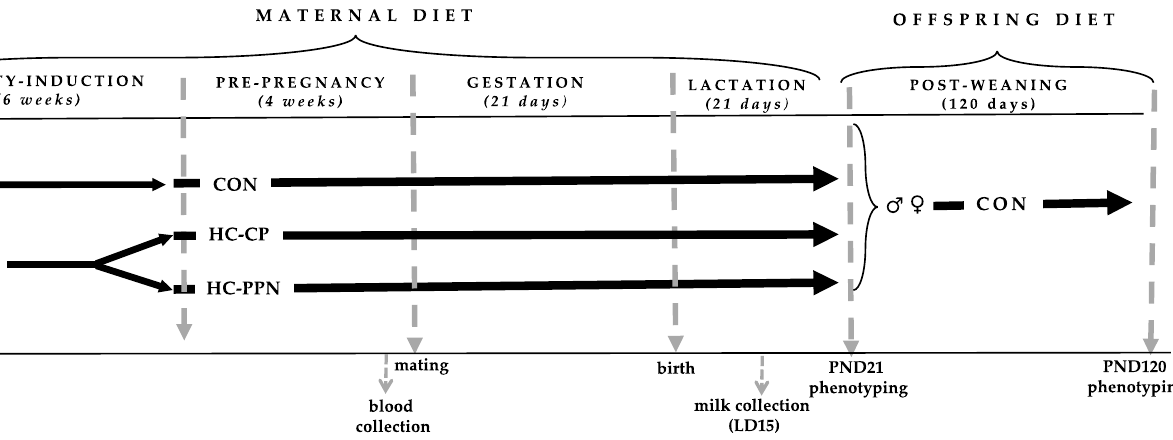
Figure 1. Experimental design. CON, low-calorie control diet; HC-CP, high-calorie obese-inducing diet with casein protein; HC-PPN, HC high-calorie diet with supplemental yellow pea protein (25%); LD, lactation day; and PND, postnatal day.